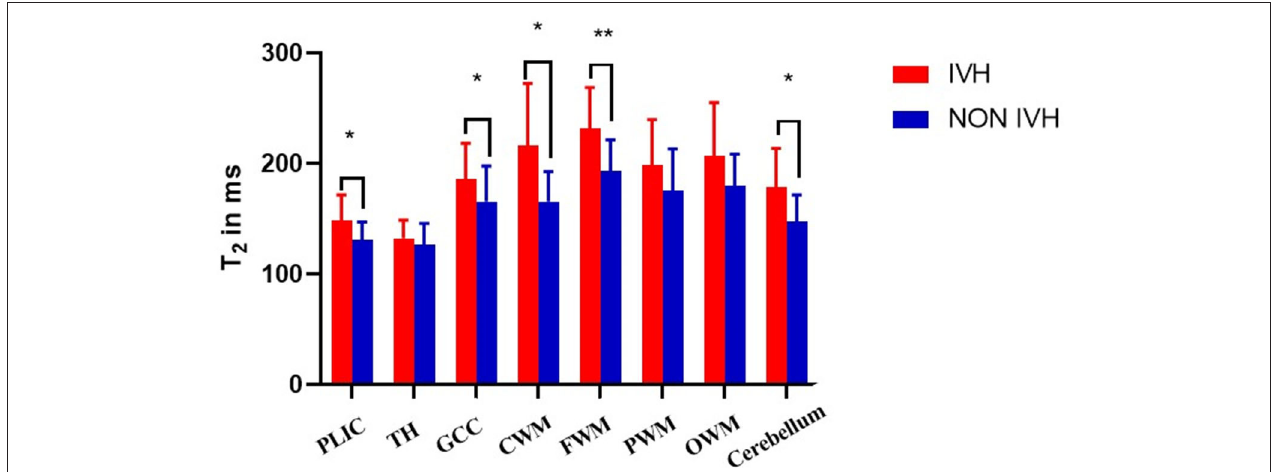
FIGURE 3 | Differences in T2 values between IVH and NON IVH groups. The IVH group is displayed in red and the NON IVH group in blue. PLIC, posterior limbs of the internal capsule; TH, thalamus; GCC, genu of the corpus callosum; CWM, Central white matter; FWM, frontal white matter; PWM, parietal white matter; OWM, occipital white matter. * p < 0.05,** p < 0.001.